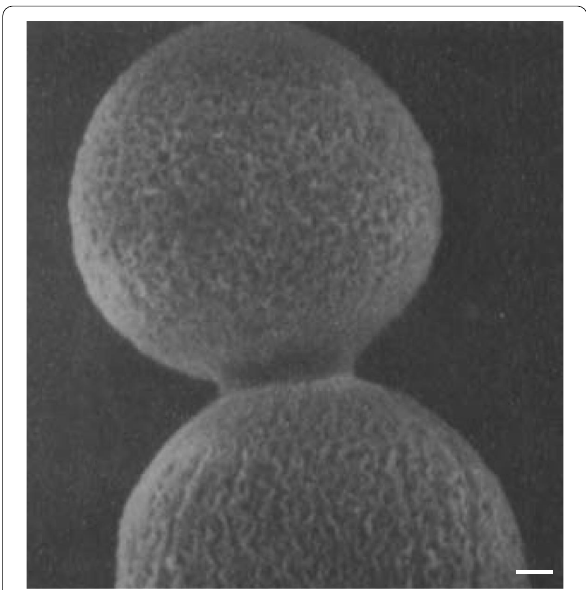
Fig. 2 Low-temperature scanning electron micrograph of stamen hair cells of the herbaceous perennial plant Tradescantia reflexa . The specimen was mounted on a cryo-stage, cooled to -15 ℃ , and observed using SEM at 10 kV for less than 10 min. Bar (Kaneko et al. 1985 with permission from the publisher)